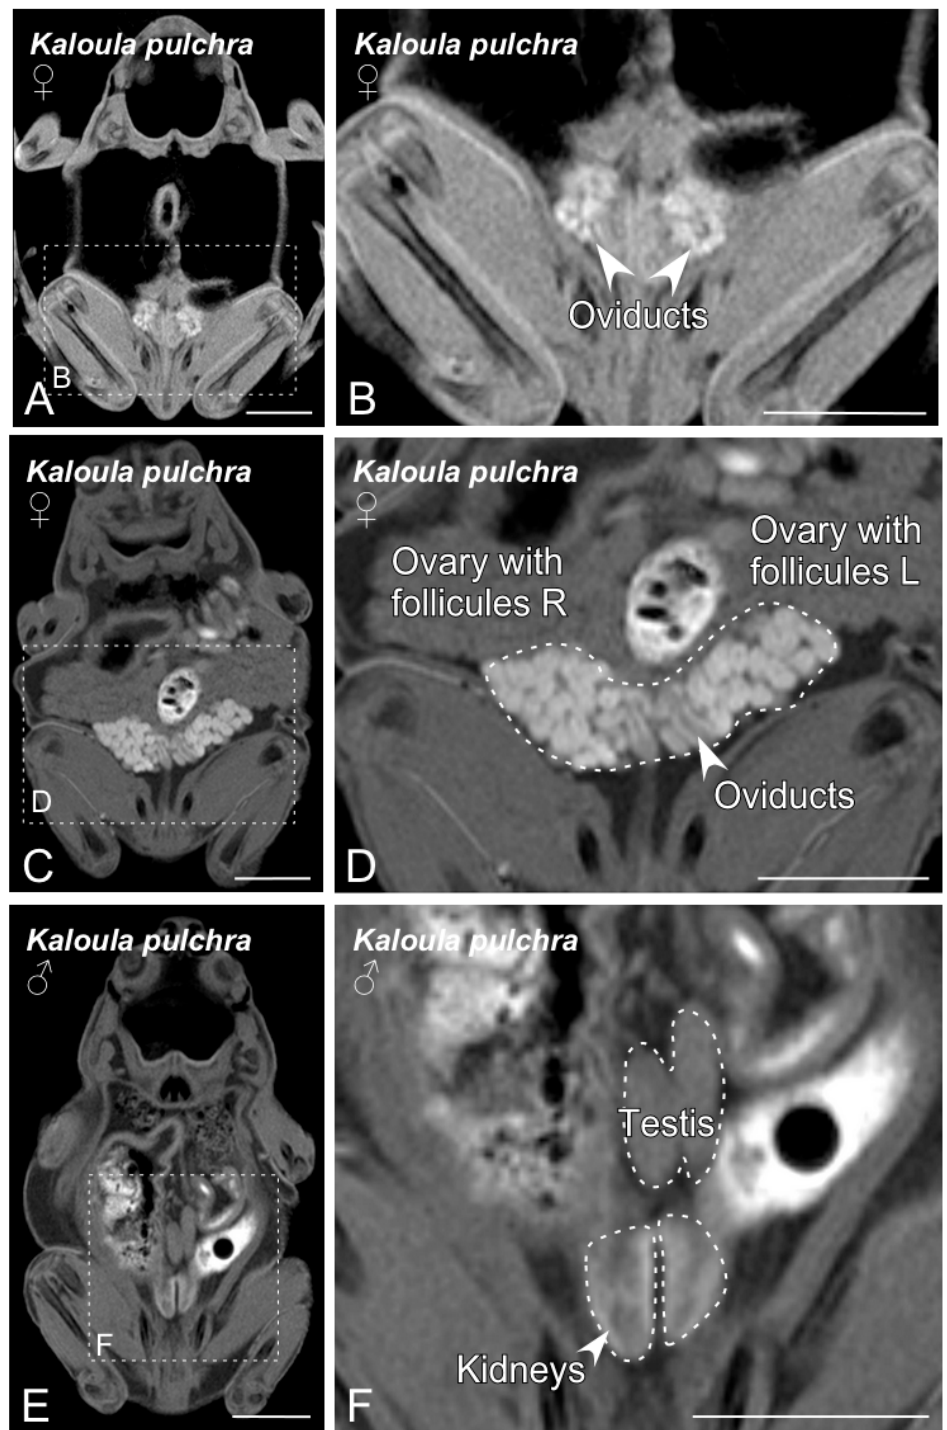
Figure 2. Magnetic resonance imaging (MRI) slices selected to classify Kaloula pulchra anurans by sex. Images from ( A ) to ( D ) show the main sexual structures identified in a non-gravid ( A , B ) and gravid ( C , D ) Kaloula pulchra female. Images ( E ) and ( F ) show testis and kidneys in a Kaloula pulchra male. The dashed lines in ( A , C , E ) indicate the magnification photos showed in ( B , D , F ). Scale bars = 1 cm.